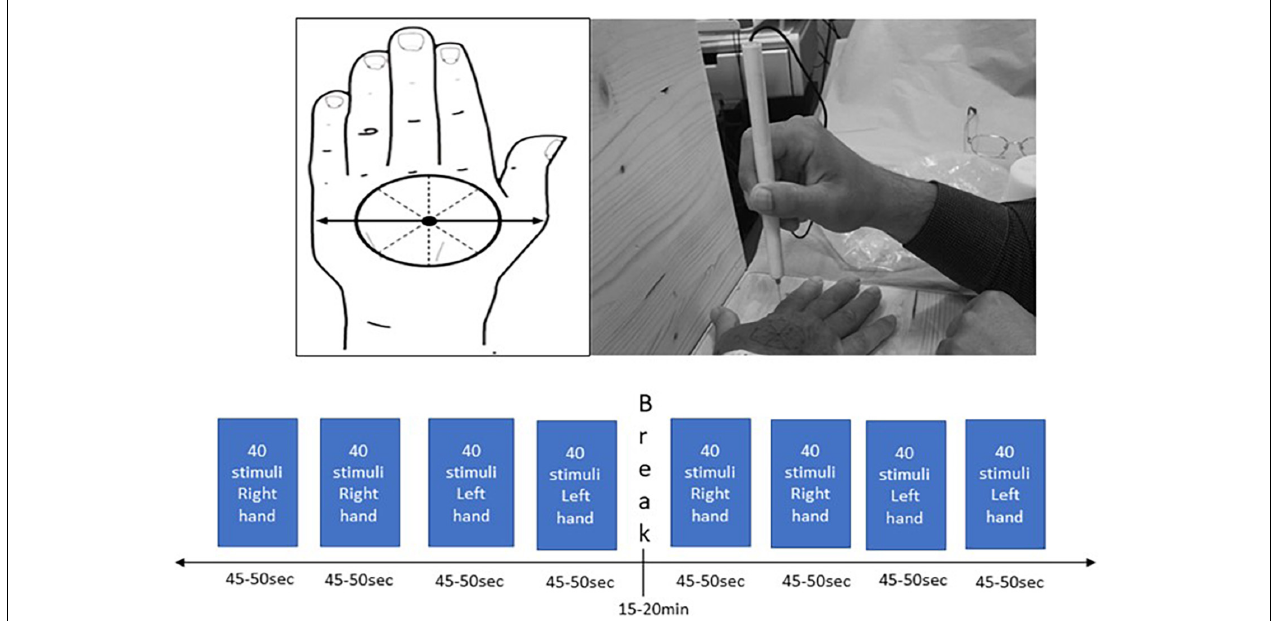
FIGURE 1 | Standardized hand marking for the pin-prick stimulation protocol on the dorsum of both hands.